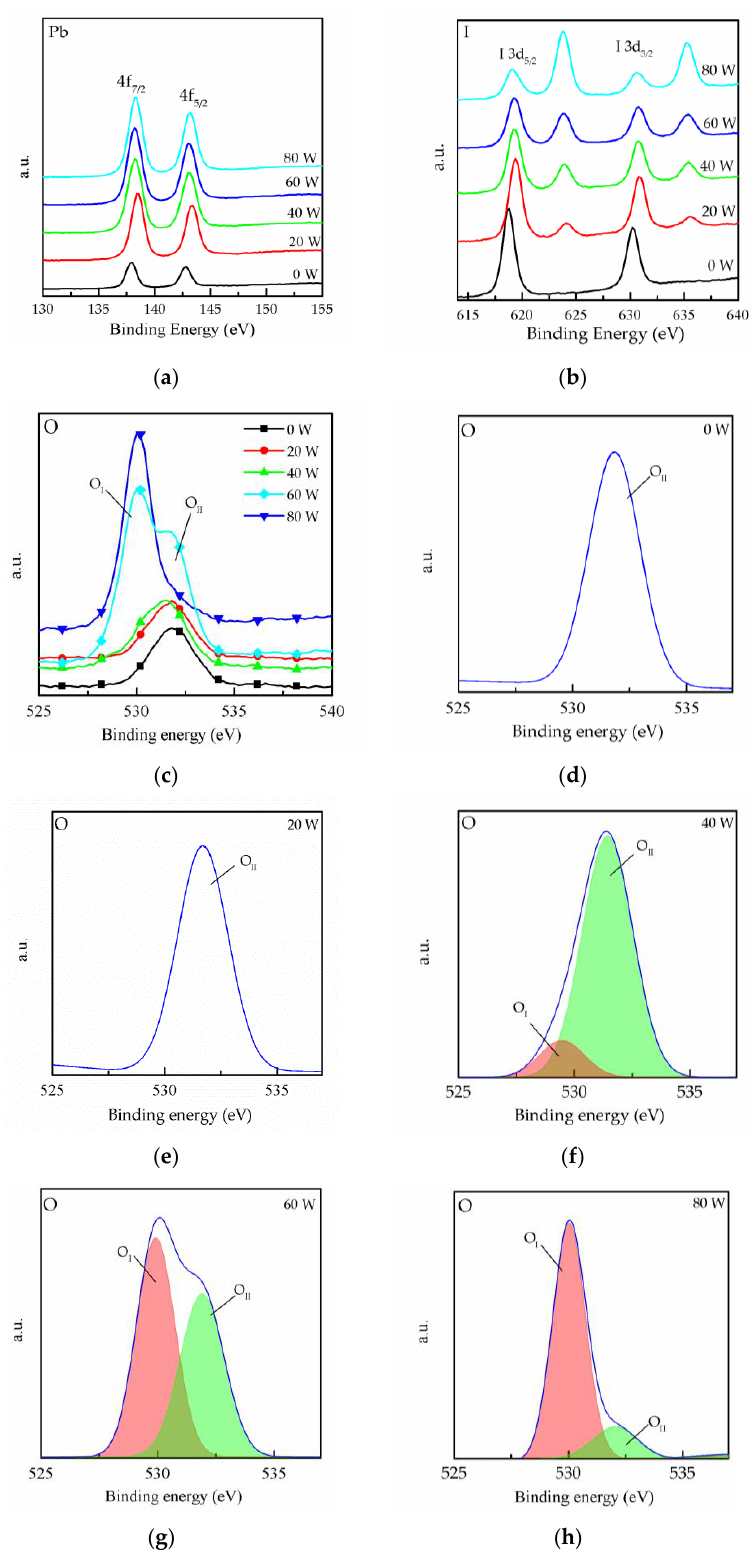
Figure 3. XPS spectra of MAPbI 3 film doped with CsPbI 3 QDs for ( a ) Pb 4f-, ( b ) I 3d- and ( c ) O 1s-treated oxygen plasma power at different powers. ( d – h ) Peak analyses of the XPS spectra for O 1s at different powers.